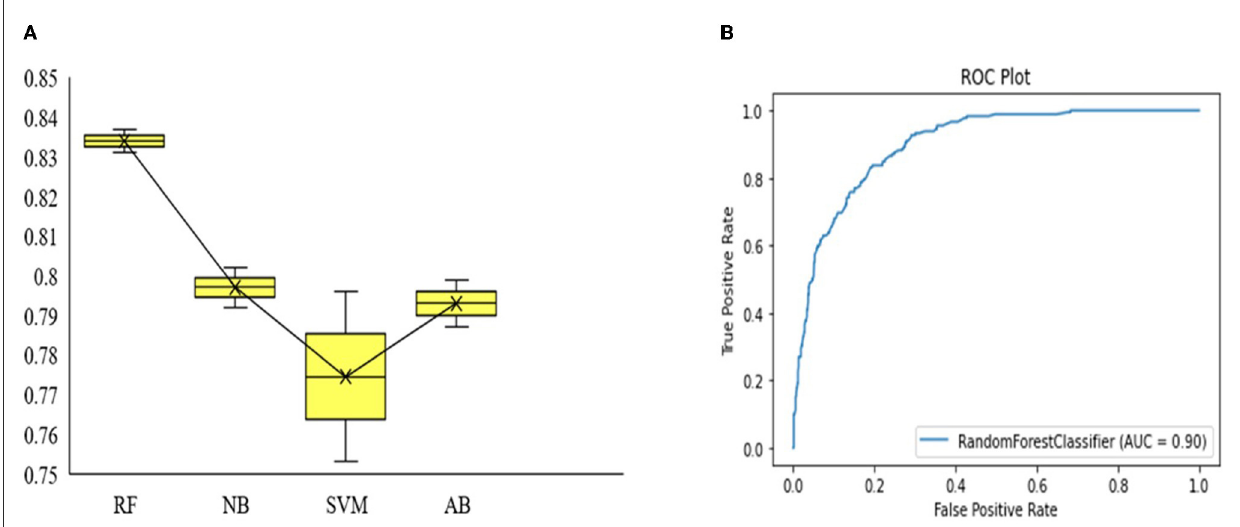
FIGURE3 Performance comparison on different machine learning classifiers by using training and independent datasets. The higher point represents the training accuracy and the lower point represents the accuracy on independent data (A). AUC curve of the anticipated model (B)